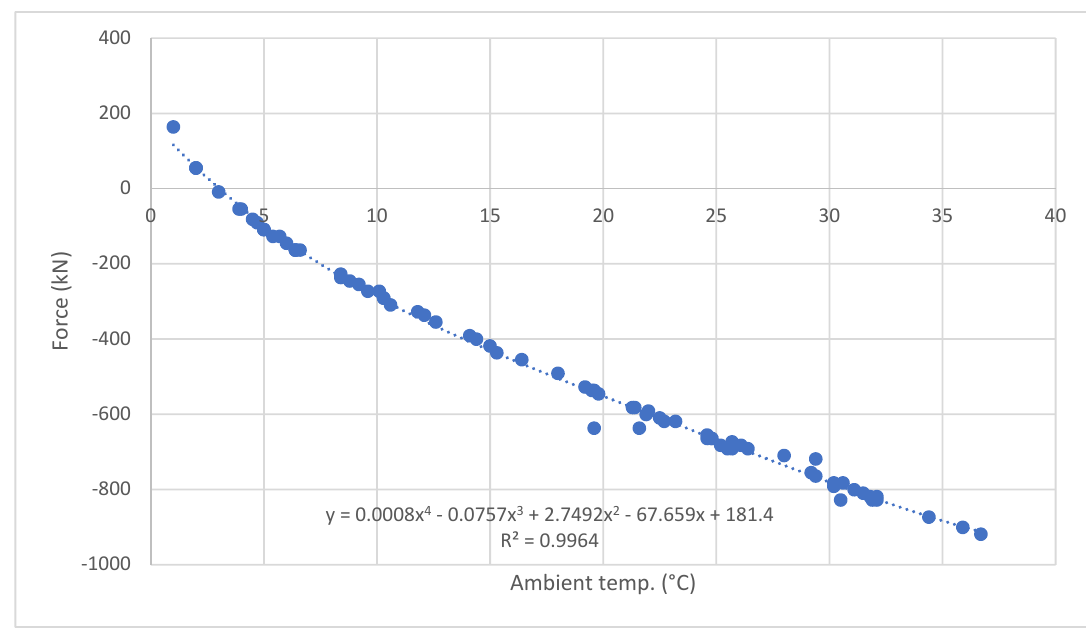
y = 0.0008x 4 - 0.0757x 3 + 2.7492x 2 - 67.659x + 181.4 R² = 0.9964 Ambient temp. (°C) Figure 15. Dependence of the longitudinal rail force without load on the ambient temperature (source: own work). Based on the measurements carried out, a dependence was obtained for which the correlation coefficient R 2 reached 0.9964, which should be considered a very good result. The dependence of the temperature of the rail under load t szo on the ambient temperature t o is presented as formula (14).